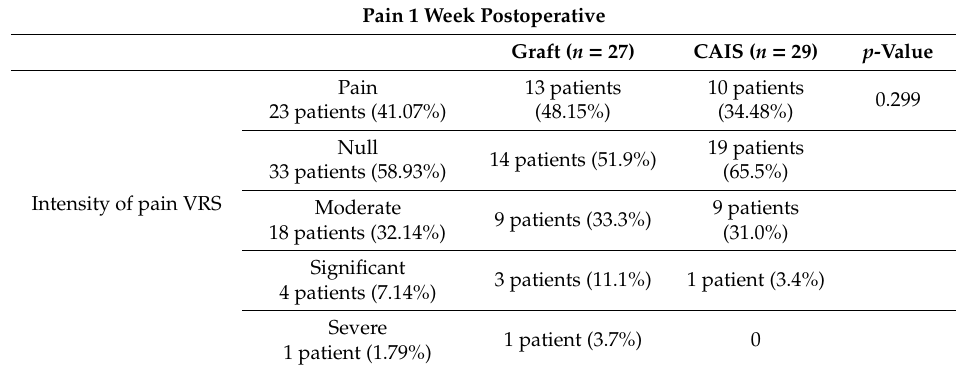
Table 4. Pain one week after